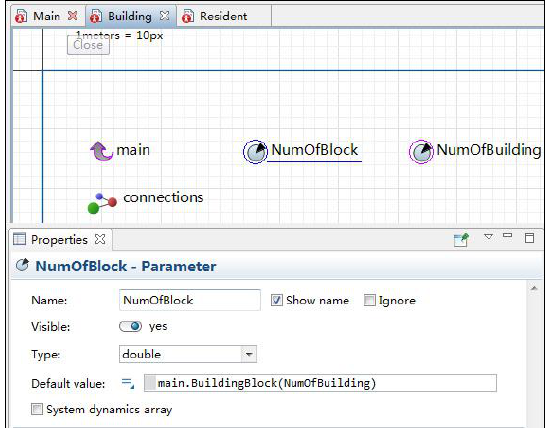
Figure 1. The setting of “Number of block”.